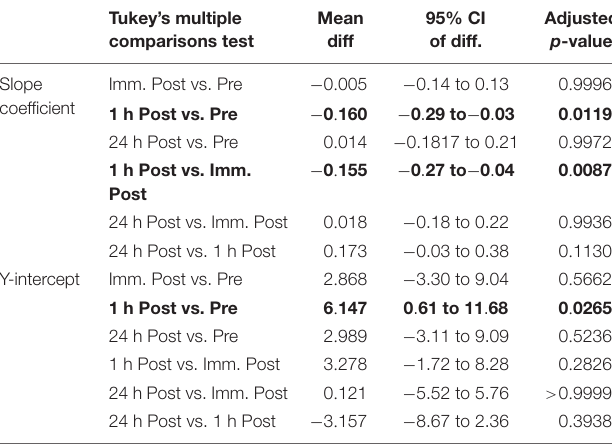
TABLE 1 | Pairwise comparisons (mean difference, 95% confidence intervals and adjusted p -values) of the slope coefficient and y-intercept (rec. thresh. Vs. MUFR). Tukey’s multiple Mean 95% CI Adjusted comparisons test diff of diff.